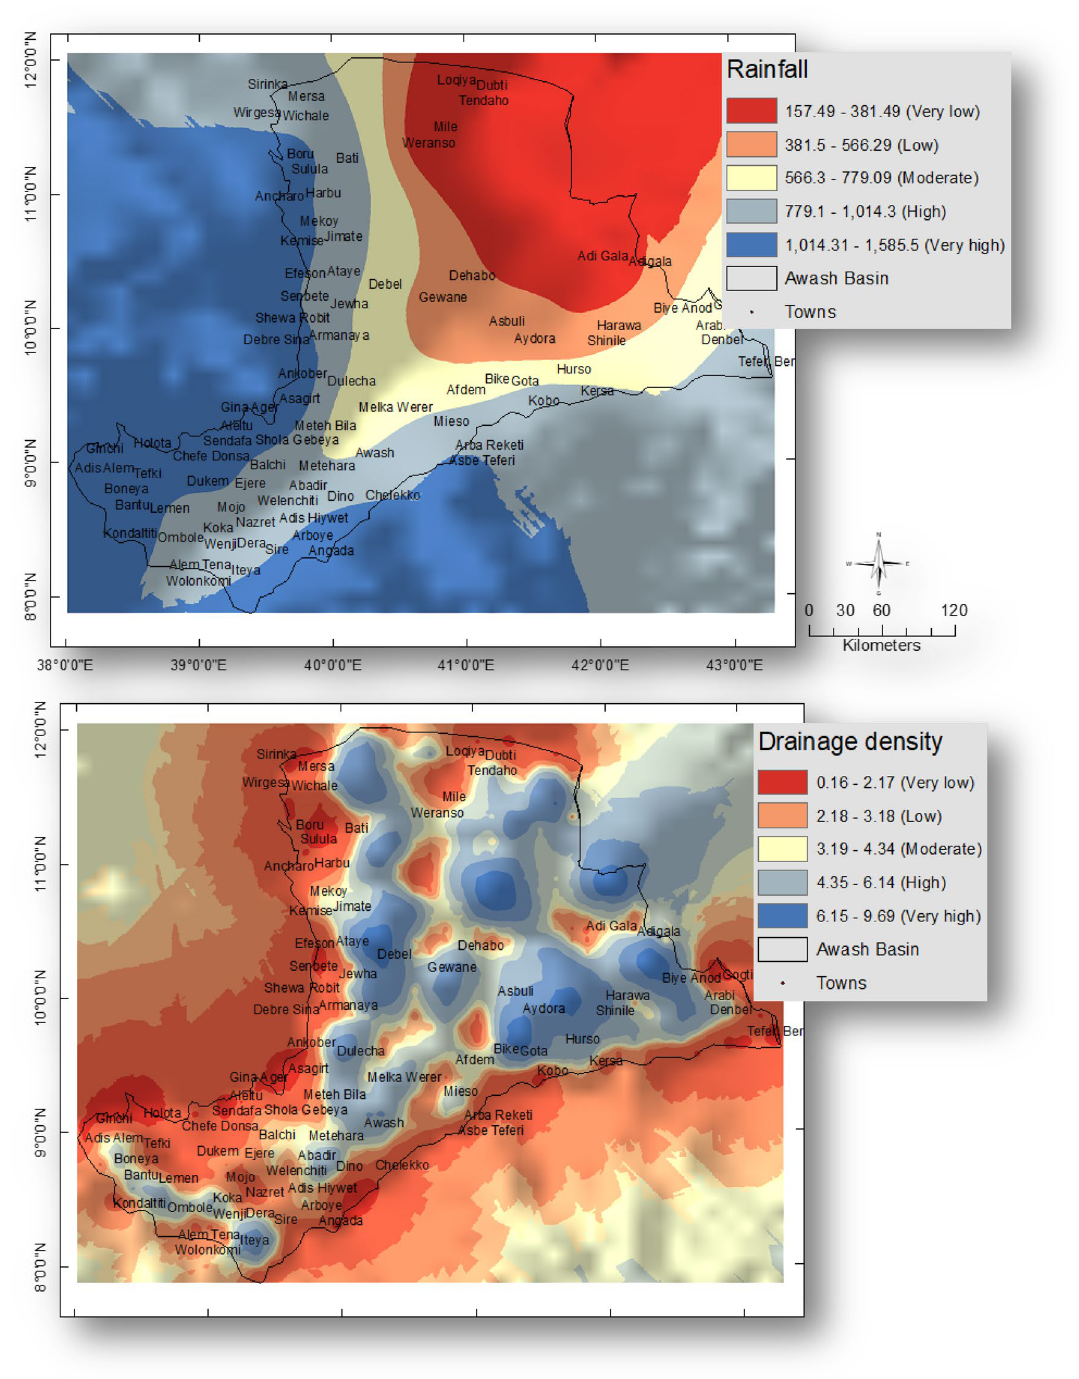
Figure 4. Weighted layers of Rainfall (mm) and Drainage density (km/km 2 ) of the Awash basin, Ethiopia. This figure was created using ArcGIS 10.3.1